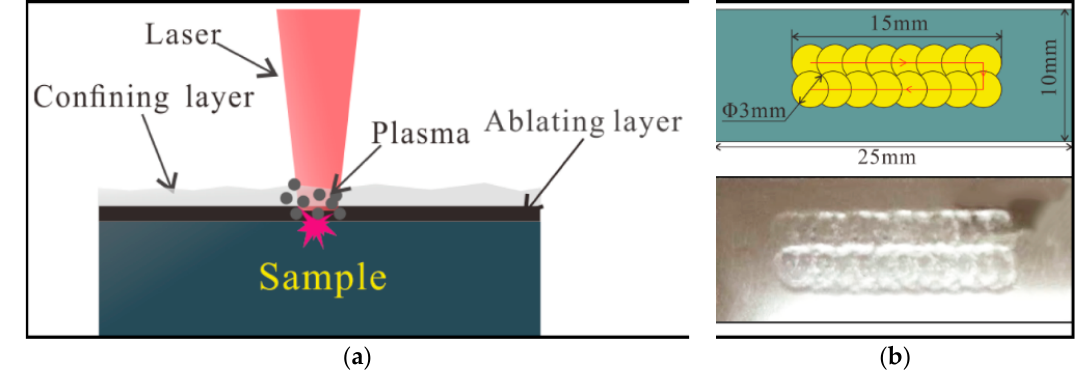
Figure 1. Principle of laser shock peening (LSP). ( a ) Laser shock peening; ( b ) LSP